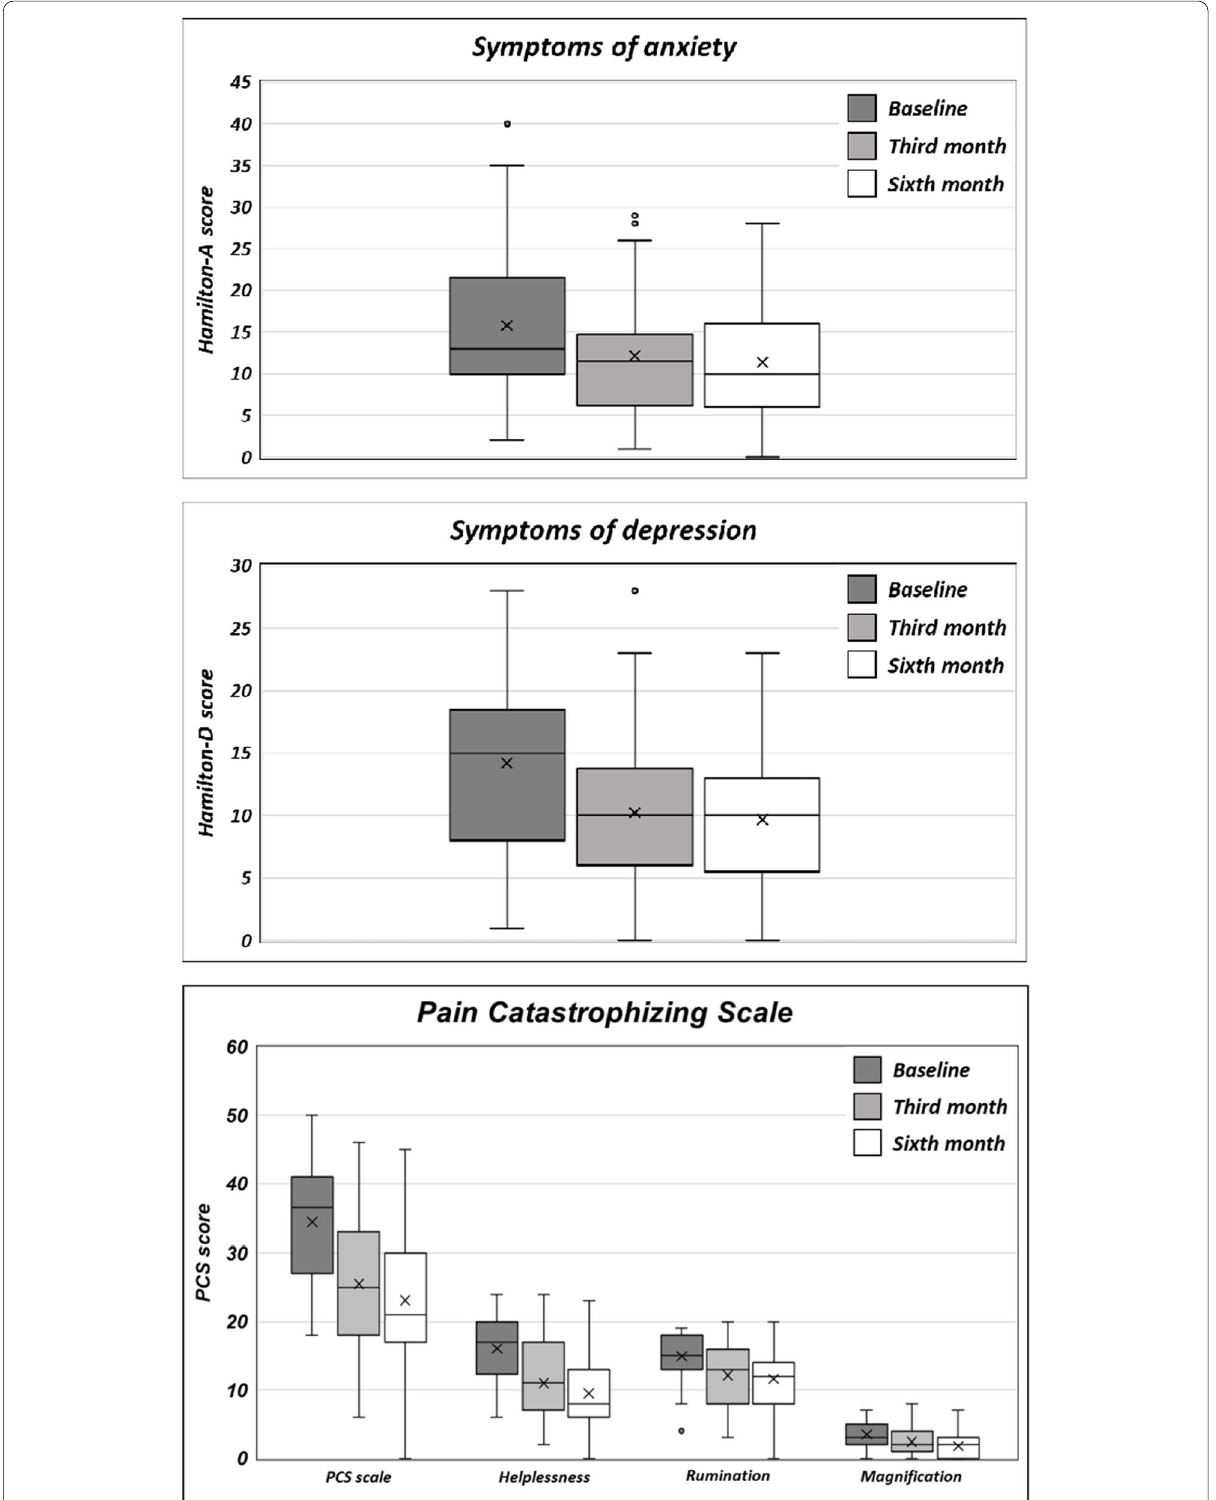
Fig. 4 Symptoms of depression, anxiety and pain catastrophizing scores at baseline (T 0 ), and at the end of the third (T 1 ) and sixth month (T 2 ) of galcanezumab